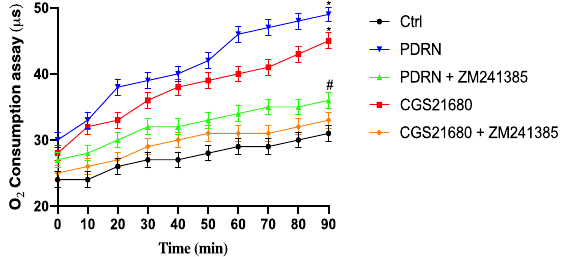
Figure 4. The graph represents the oxygen consumption in the 3T3L1 cell line. Values are expressed as the means and SD. N = 3 experiments; * p < 0.0001 vs. CTRL; # p < 0.0001 vs. PDRN.